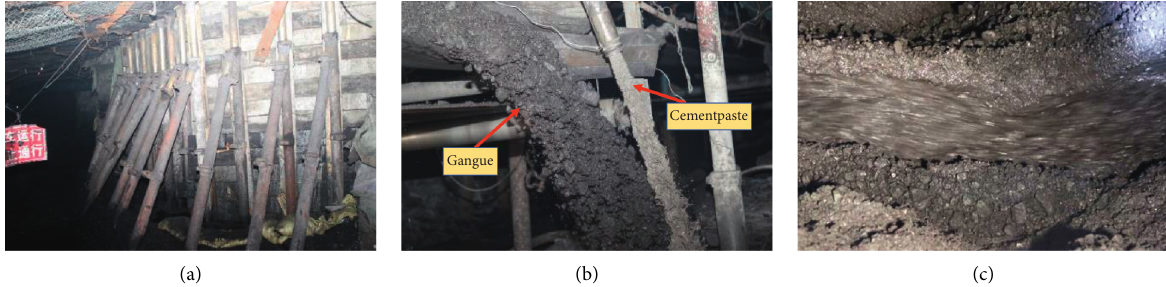
Figure 6: Filling slurry plugging and self-filling. (a) Plugging device. (b) Slurry mixing. (c) Self-flowing slurry.